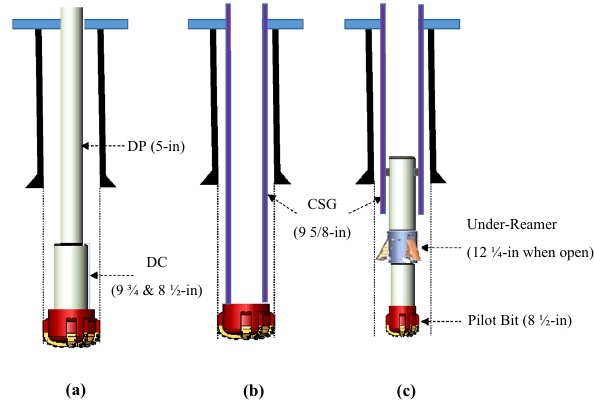
Fig. 14 a Conventional drill string, b non-retrievable CWD BHA and c retrievable CWD BHA for drilling the 12 ¼-in. hole